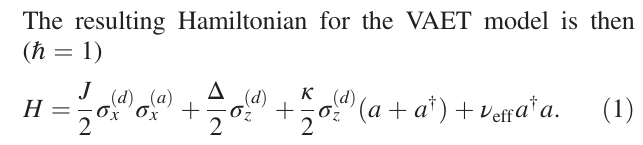
FIG. 1. (a) Schematic illustrations of the VAET process and time dynamics of the target state population in various regimes. Without the presence of an environment ( κ ¼ 0 , left drawings), the transition probability from donor to acceptor states is attenuated in the presence of an energy barrier Δ . By coupling to an environment ( κ > 0 , right drawing), an excitation can move between donor and acceptor sites by exchanging energy with a phononic environment. Time traces illustrate the three situations: (1) Δ ¼ 0 : black trace (theory) and data points ( ∘ ). (2) Δ > J , without assistance from the environment: blue trace (theory) and data points (×). (3) Δ > J , with assistance from the environment (VAET process): red trace (theory) and data points ( ⋄ ). (b) Schematics of the ion trap and laser beams generating the simulated Hamiltonian. Internal levels of the ions (blue spheres) serve as energy sites. A laser beam illuminating both ions generates the site-site coupling with strength J . A localized beam generates the coupling to the environment with strength κ and controls the detuning Δ . (c) Laser tones (orange arrows) generating the simulated Hamiltonian. Vertical black lines represent available transitions, with the atomic resonance of the respective ion in the center. The detuning Δ is introduced via an ac-Stark shift by imbalancing the relative power of the two tones of the local beam, as indicated in the